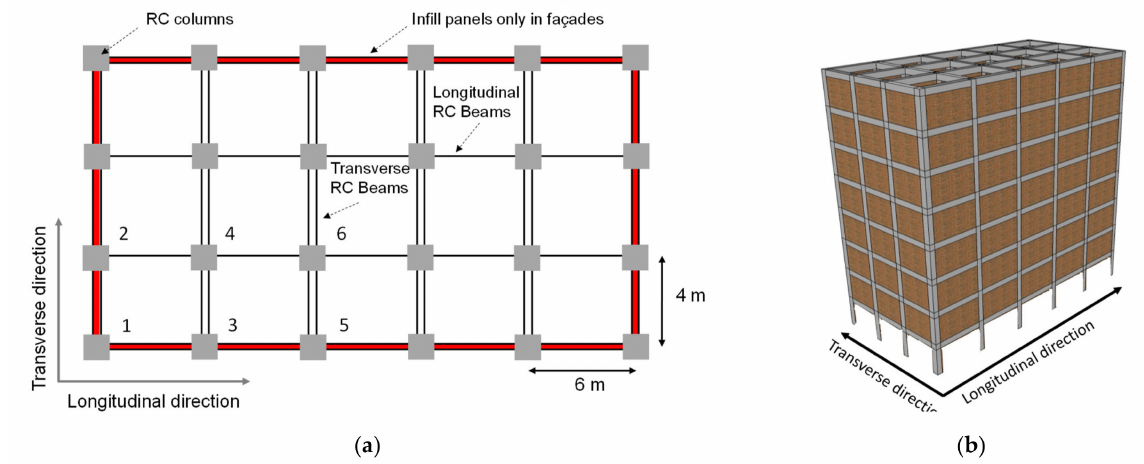
Figure 24. Case study: ( a ) plant disposition and ( b ) 3D bare frame model.